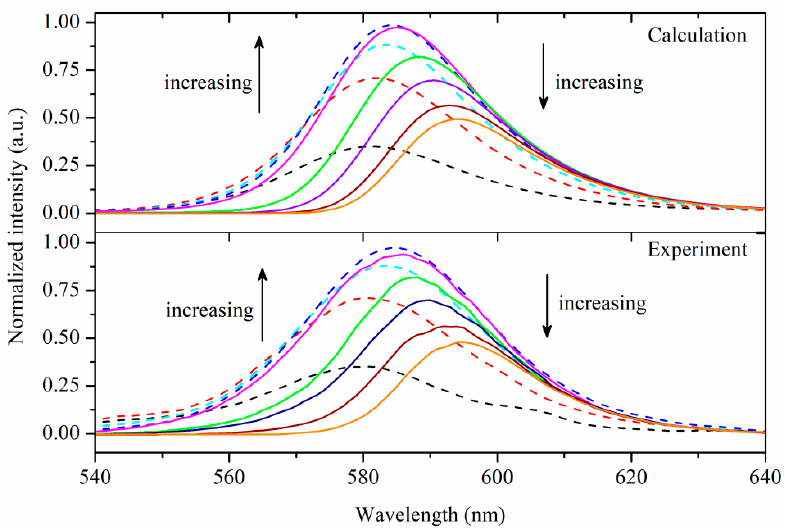
Figure 3. The comparison of s pontaneous emission spectra between calculation and experiment under different fiber lengths (1–15 cm) in which the directions of the arrows represent the increase of the fiber length from 1 to 2, 3, 4, 5, 7, 10, 12, and 15